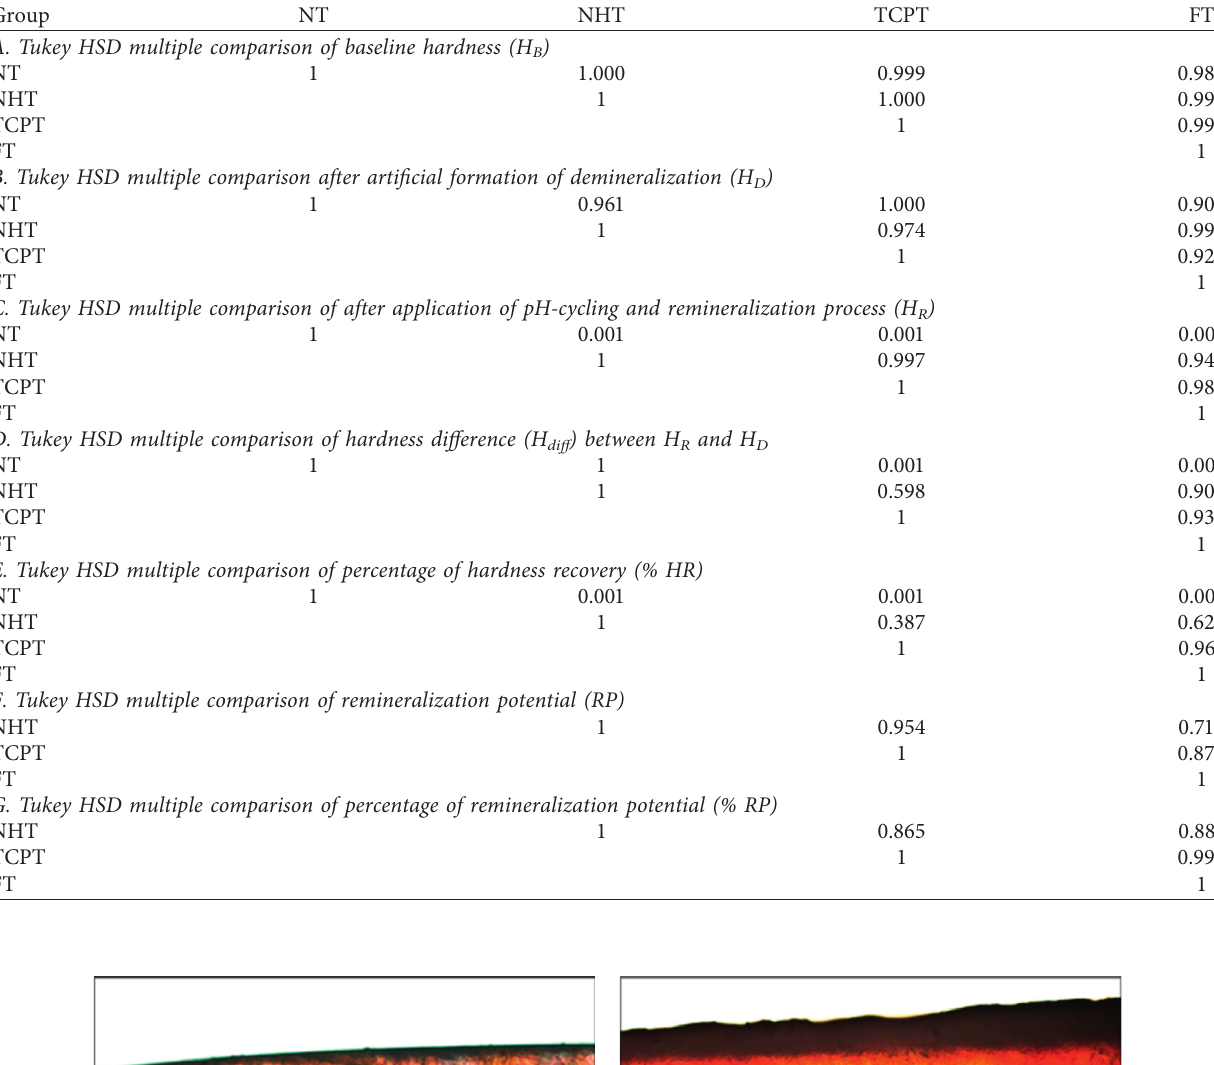
Table 4: Post hoc Tukey’s multiple comparisons of baseline hardness ( H